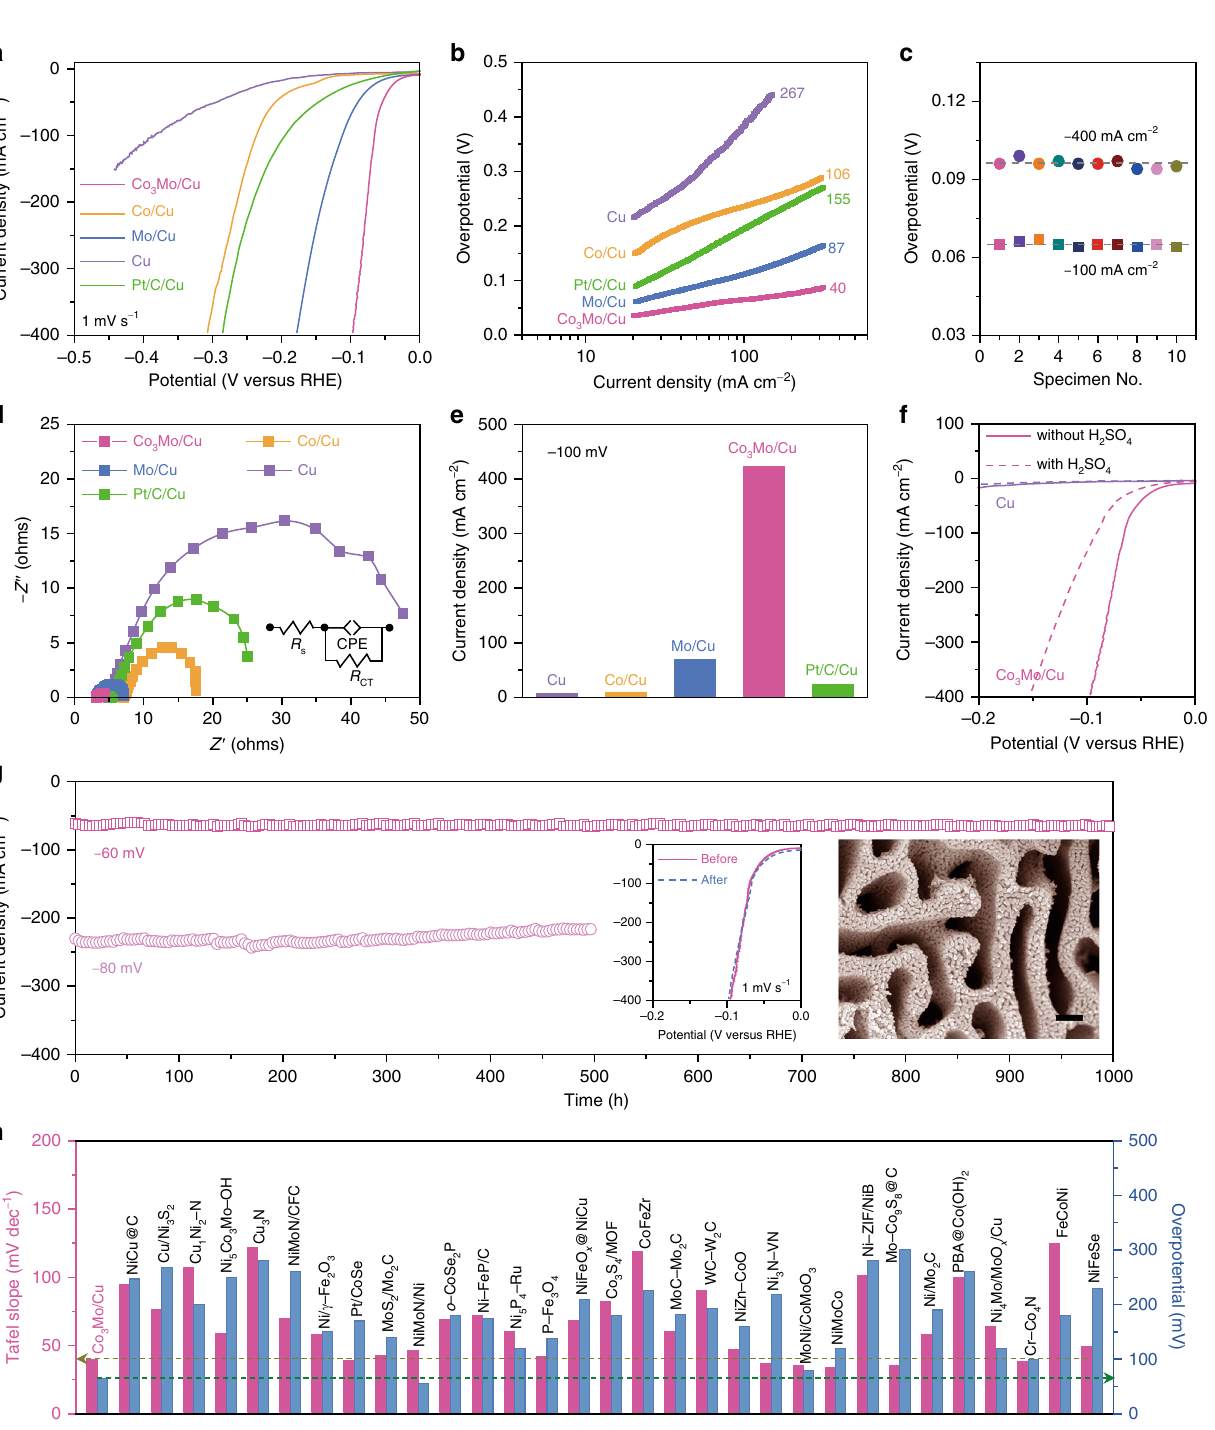
Fig. 3 Electrochemical characterization on HER properties. a iR-corrected HER polarization curves for self-supported nanoporous Co 3 Mo/Cu, Co/Cu, Mo/Cu, and Cu electrodes, as well as commercially available Pt/C immobilized on nanoporous Cu (Pt/C/Cu) in 1 M KOH. Scan rate: 1 mV s − 1 . b Comparison of the Tafel plots of different electrocatalytic materials obtained from the HER polarization curves in panel ( a ). c Overpotentials at current densities of 100 and 400 mA cm − 2 for ten nanoporous Co 3 Mo/Cu electrodes that are prepared by the same alloying/dealloying procedure. d EIS spectra of nanoporous Co 3 Mo/Cu, Co/Cu, Mo/Cu, and bare Cu electrodes and nanoporous Pt/C/Cu. e Comparison of current density at − 100 mV for nanoporous Co 3 Mo/Cu electrode with the values of nanoporous Cu, Co/Cu, Mo/Cu electrodes, and nanoporous Pt/C/Cu. f iR-corrected HER polarization curves of nanoporous Co 3 Mo/Cu and bare Cu electrodes before and after H 2 SO 4 treatment. g Long-term stability measurement of nanoporous Co 3 Mo/Cu electrode at the overpotentials of 60 and 80 mV for more than 1000 and 500 h, respectively. The negligible current fl uctuation is due to the depletion/ replenishment of electrolyte. Insets: SEM image after the durability measurement at 60 mV for 1000 h and polarization curves before and after the durability measurement. Scale bar: 300 nm. h Tafel slope and overpotential at 100 mA cm − 2 of nanoporous Co 3 Mo/Cu electrode, comparing with the values of representative HER catalysts reported